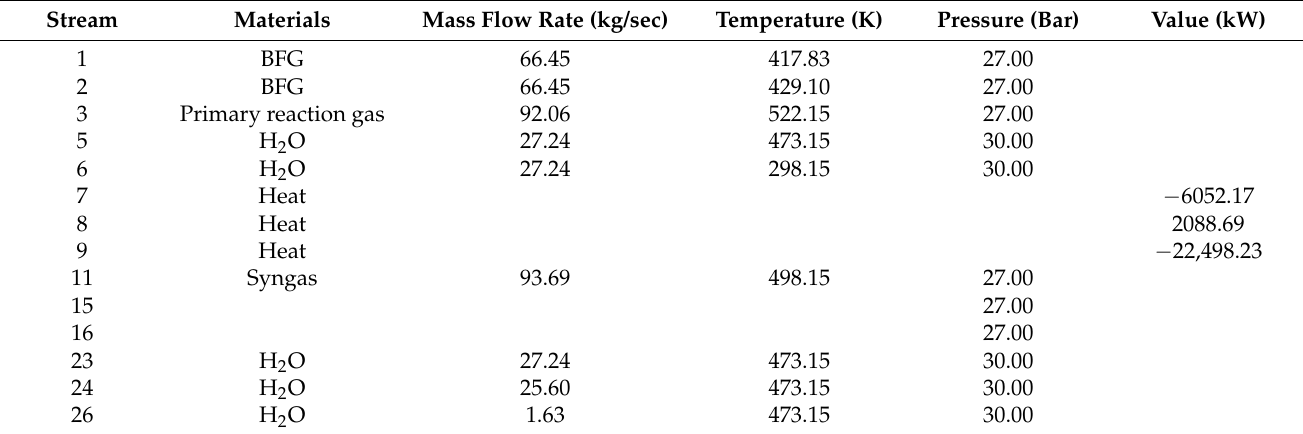
Table 2. Stream parameters in SHIFT.